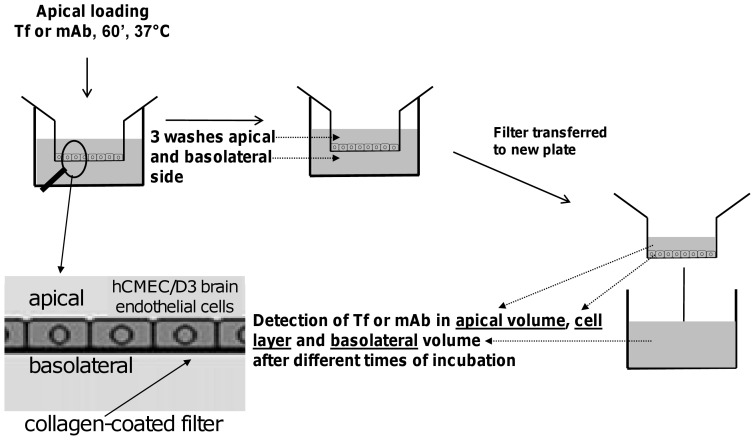
Description of the transcytosis assay.hCMEC/D3 cells grown to confluence on collagen and fibronectin coated membrane filter inserts (and serum starved for 1 h at 37°C before assay for experiments with 125I-transferrin) were incubated apically with the ligand or the different antibodies for 60 min at 37°C. After 1 hr, media from the apical and basolateral chambers were collected to assess paracellular flux following which the luminal and abluminal membranes of the monolayer were washed four times with medium at RT and the washes monitored to determine efficiency of removing unbound antibody. The filters containing cells were transferred to a fresh plate containing pre-warmed medium and cells were chased up to the desired time points at 37°C or on ice and at these different time points, the ligand or antibody associated with cells or in the media from the apical and basolateral chambers was analyzed in a gamma counter or assessed by IgG ELISA.